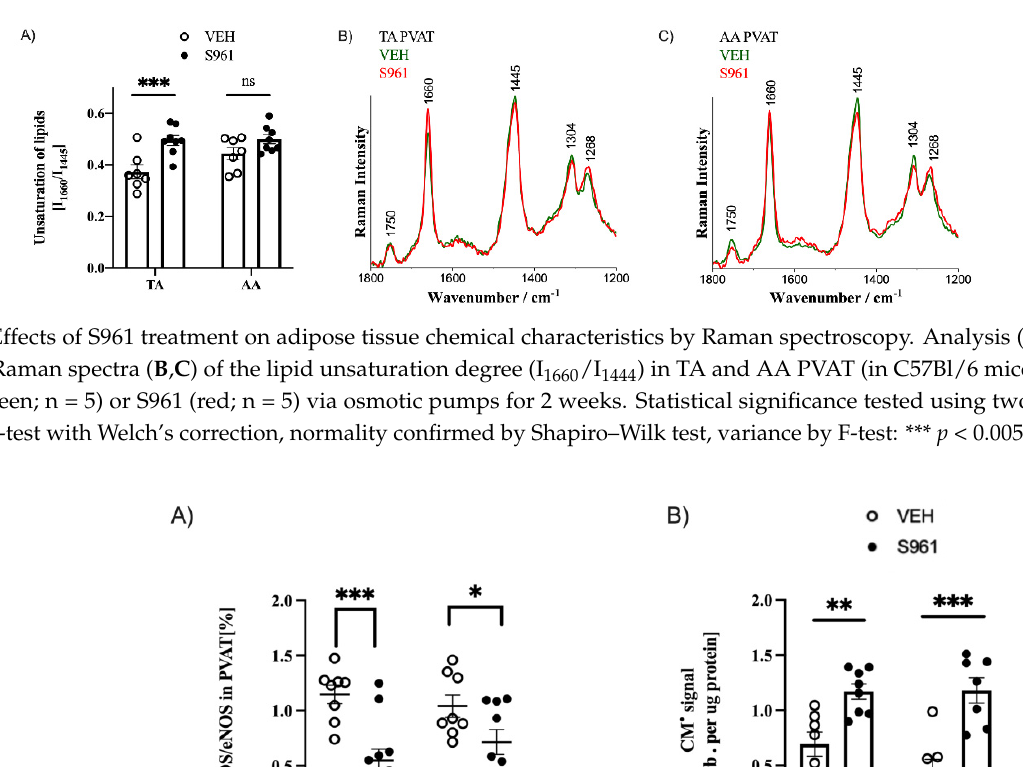
Figure 5. Effects of S961 treatment on adipose tissue chemical characteristics by Raman spectros-